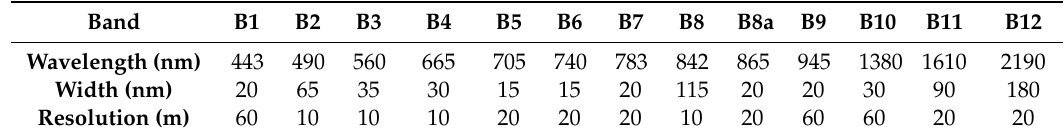
Table 1. The band details for Sentinel-2.